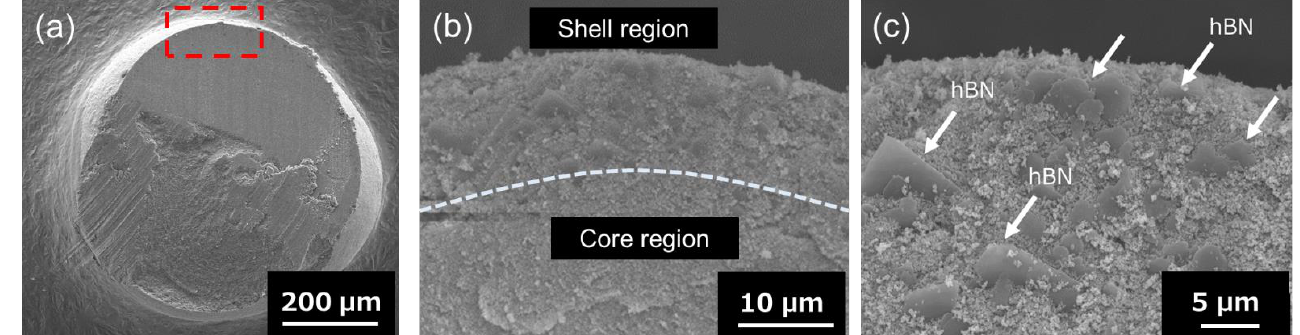
Figure 4. ( a ) Cross-sectional SEM images of an Al 2 O 3 – hBN CS composites granule. ( b ) The higher magnification image of the interface between the core and shell region, marked with the red-dotted line in ( a ). The interface between the core and shell region is marked with dotted line. ( c ) Zoomed-in SEM image of the shell region indicating the presence of hBN sheets (arrow marked).